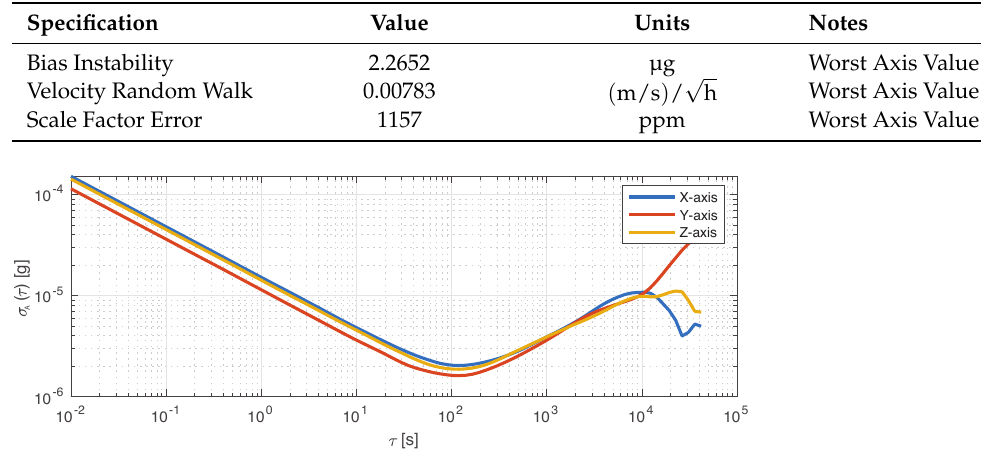
Figure 13. Allan variance, σ A ( τ ) , for Memsense MS3025M